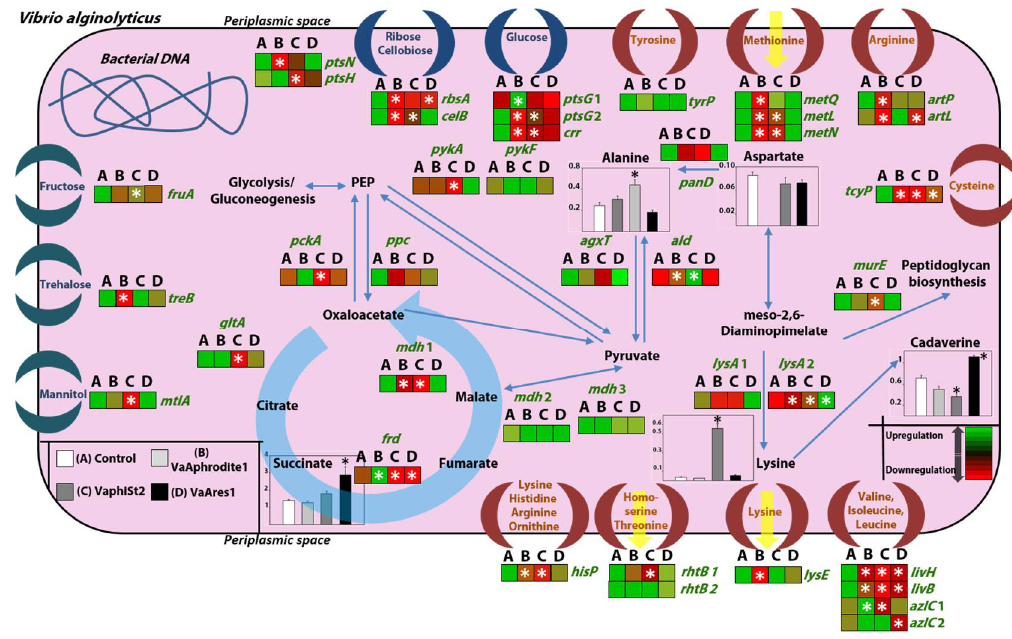
Figure 6. Schematic representation of metabolic reprogramming that takes place in phage-resistant strains. Relative transcript levels (heat maps) of sugar–polyol transporters (blue crescent moon) and amino acid transporters (brown crescent moon) of the inner bacterial membrane, accompanied by genes that are involved in important biochemical intracellular pathways of phage-susceptible (A) and phage-resistant (B, C, D) strains. Bars represent relative content levels of intracellular metabolites ( ± SE) in susceptible (white) and resistant strains in bacteriophages Aphrodite1 (light grey), phiSt2 (dark grey), and Ares1 (black). Blue arrows represent biochemical pathways in brief; the light blue round arrow represents part of the TCA cycle; yellow arrows represent putative extraction of metabolites through membrane proteins. White and black asterisks represent statistically significant differences between phage-susceptible strains and phage-resistant strains (ANOVA, post-hoc analysis Student’s t -test, p < 0.05).